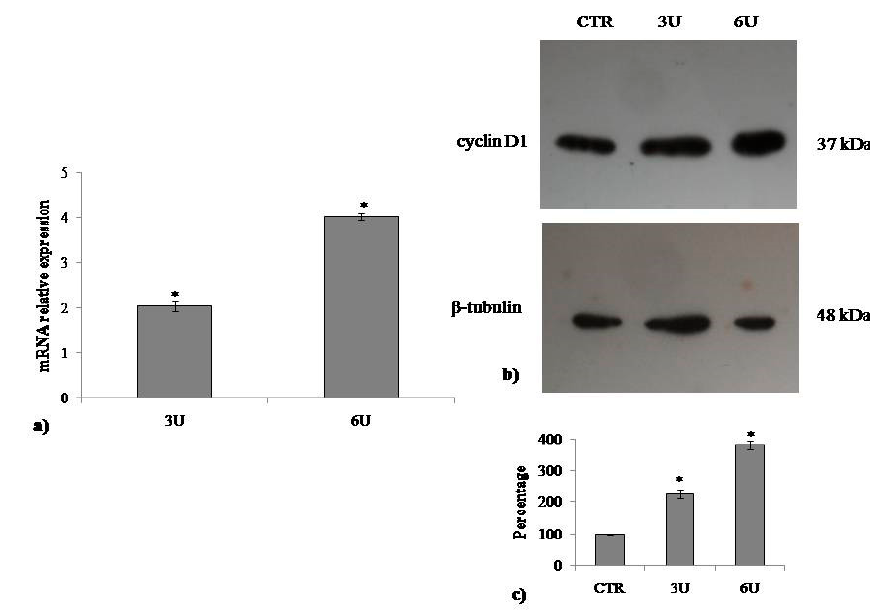
Figure 6. E ff ect of nSMase on cyclin D1. ( a ) Gene expression evaluated by RT-PCR; ( b ) immunoblotting, with the position of the 37 kDa protein for cyclin D1 and 48 kDa for β -tubulin indicated in relation to the position of molecular size standards; ( c ) area density evaluated by densitometry scanning and analyzed with ImageJ program. Values of cyclin D1, normalized with β -tubulin, are expressed as fold changes with respect to the control sample, which is considered equal to 1. Significance, * p < 0.001 versus control sample.